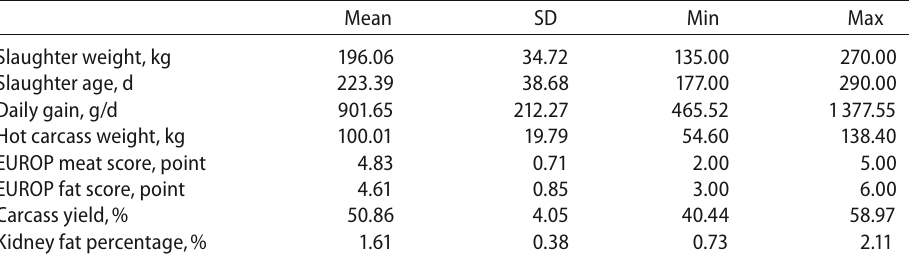
Slaughter data of male buffalo calves